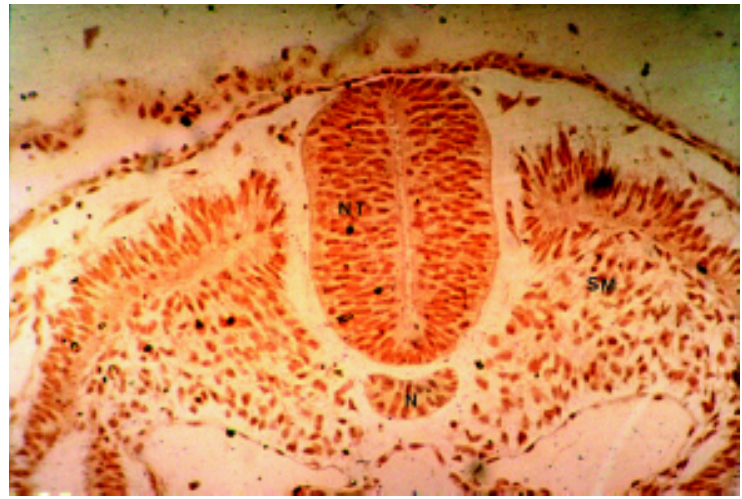
Figure 2 - Transverse section of a chicken embryo (56-h incubation) showing the silver-stained nuclei of cells in the neural tube (NT), notochord (N) and somite